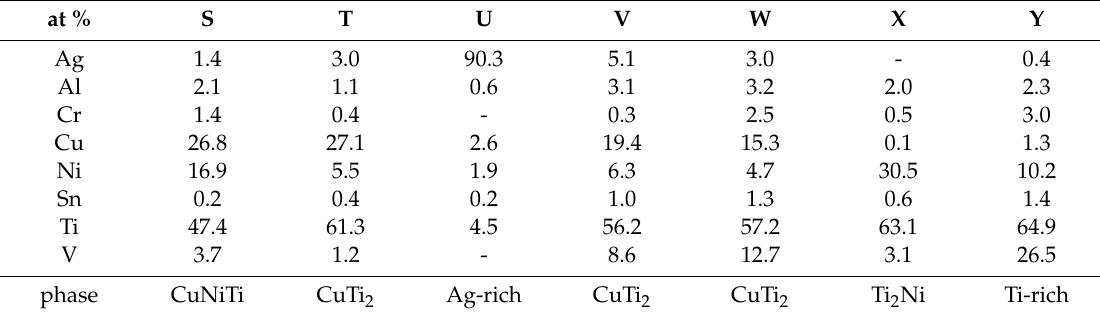
Figure 7. FESEM BEI observations of Ti 50 Ni 50 / Ticusil ® / Ti-15-3 joints brazed at ( a ) 900 and ( b ) 950 °C for 300 s. Table 5. Chemical analyses in Figure 7